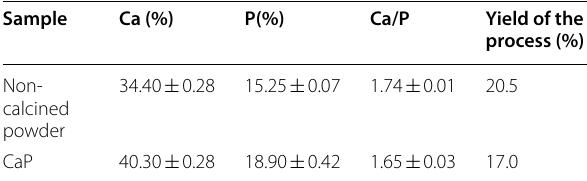
Table 3 Calcium and phosphorus content (wt %) and Ca/P molar ratio for the non-calcined powder and CaP sample